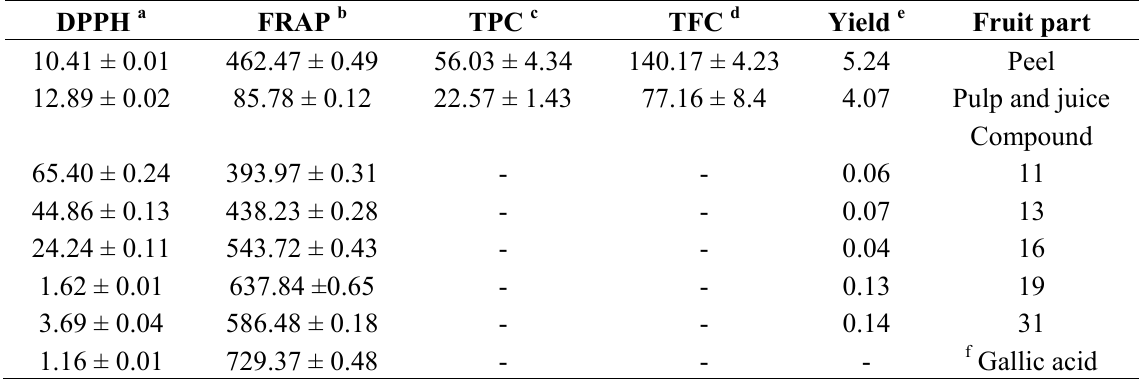
Table 1. Antioxidant power as determined by the DPPH bleaching assay, ferric reducing antioxidant power (FRAP), total phenolic content (TPC), total flavonoid content (TFC) and yield of tumbo fruits extracts and isolated